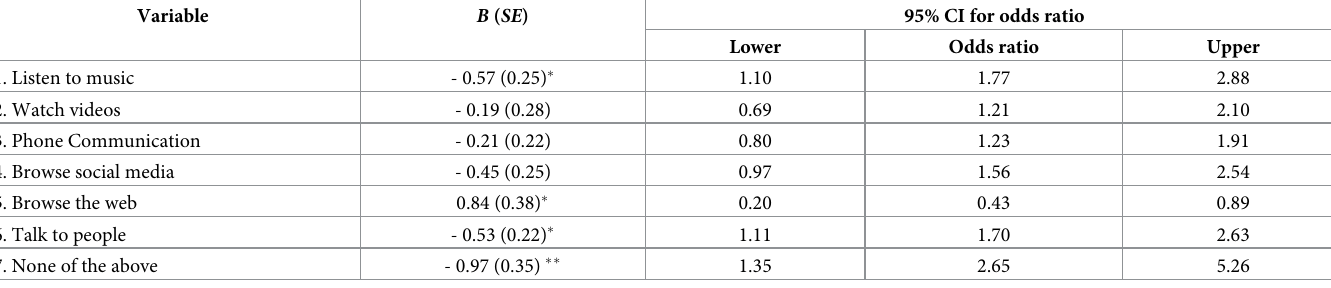
Table 4. Logistic regression analysis predicting study patterns with multitasking activities.